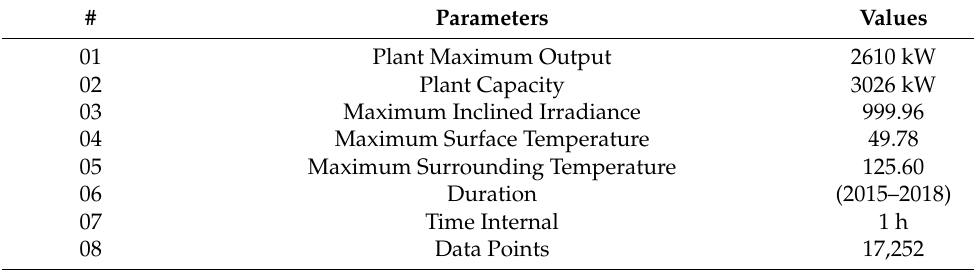
Table 1. Detailed description of the solar dataset with parameters and units.